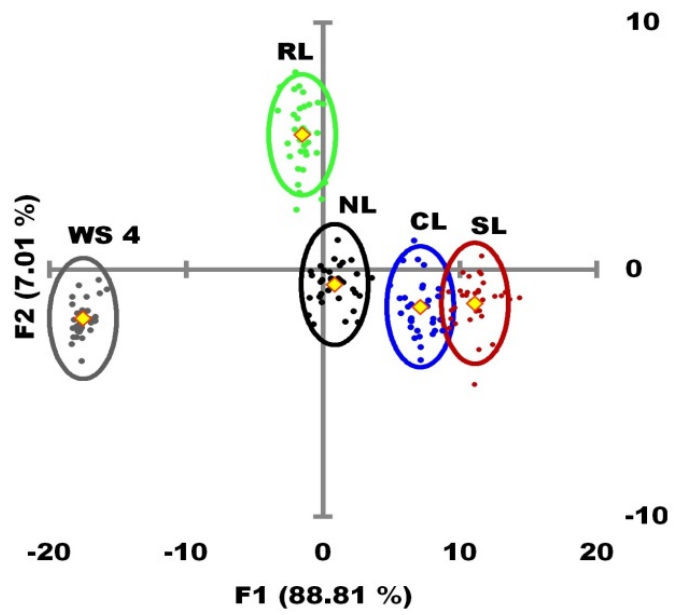
Figure 2. Discriminating functions, 95% confidence ellipses, and group centroids (diamonds).